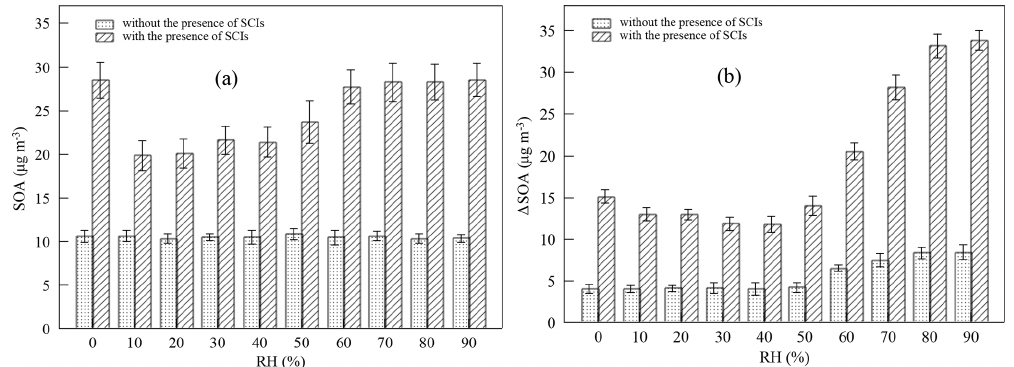
Figure 3. Impact of the presence of SCIs on (a) SOA mass concentration (SOA) in the first-generation oxidation and (b) the increment of SOA mass concentration ( (cid:49) SOA) in the second-generation oxidation at different relative humidity (RH) levels.